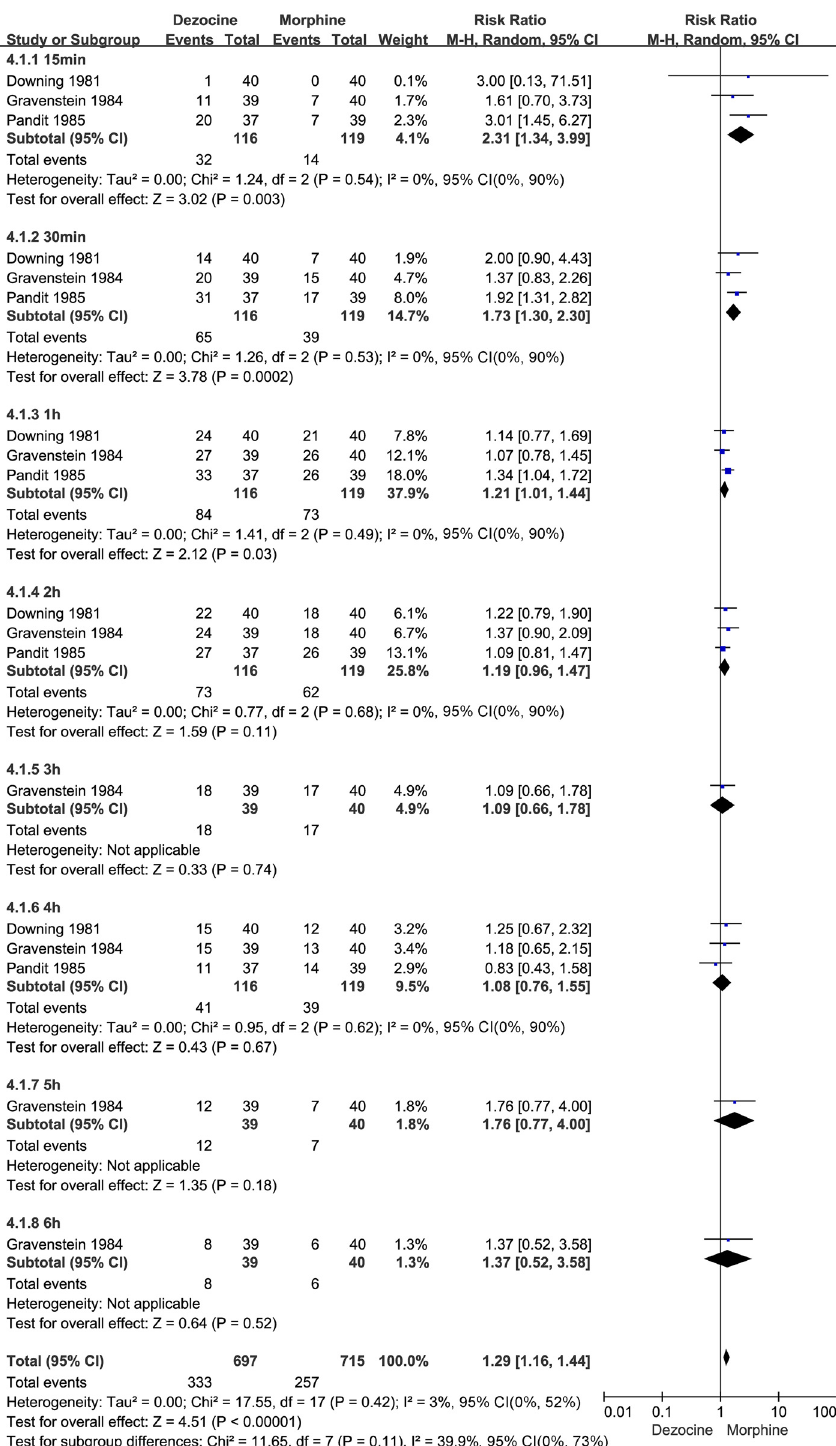
PLOS ONE | DOI:10.1371/journal.pone.0136091 August 19,